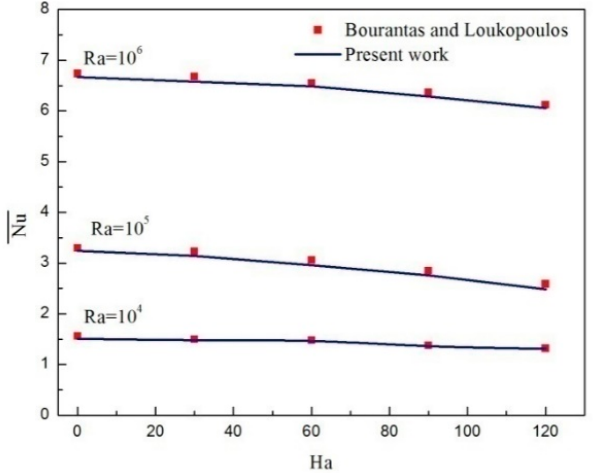
Figure 4. Average Nusselt number comparison with Bourantas and Loukopoulos [41] for Ra = 10 5 , Pr = 6.2, K = 2 and φ = 0.04. Pr = 6.2, K = 2 and ϕ =